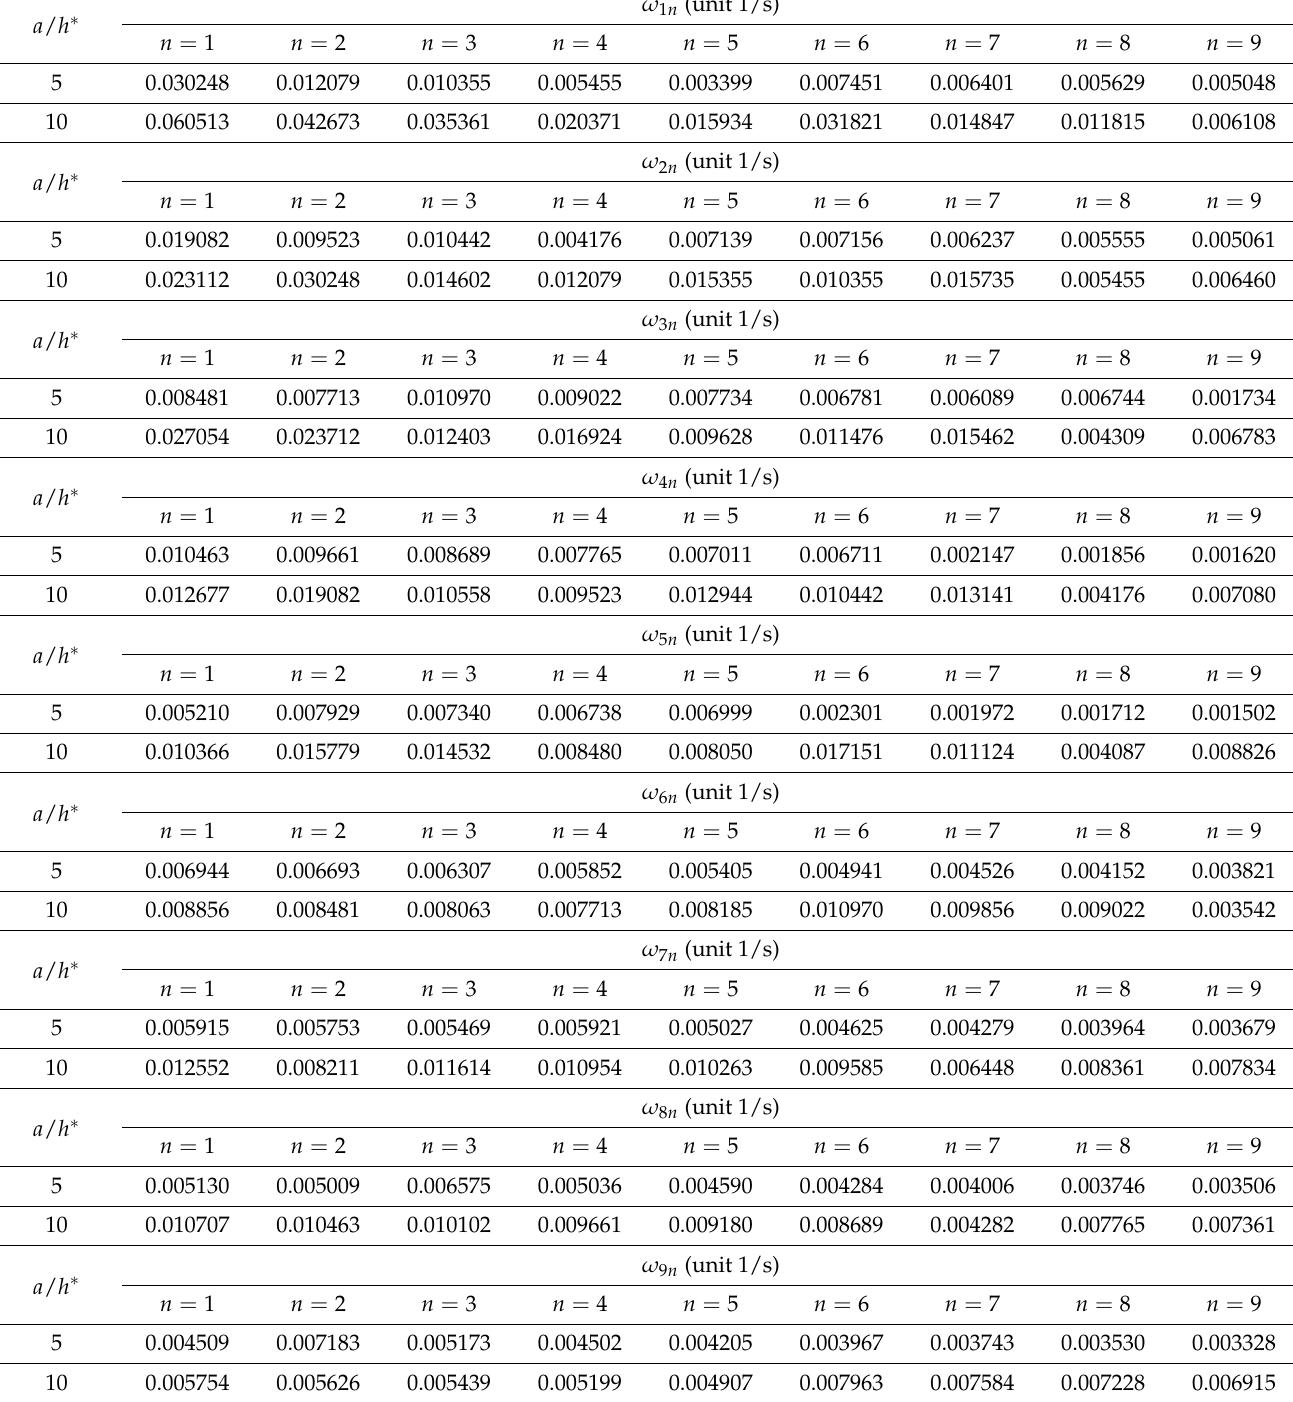
Table A1. ω mn vs. m and n under nonlinear varied k α , c 1 , R n = 0.5 and T = 300